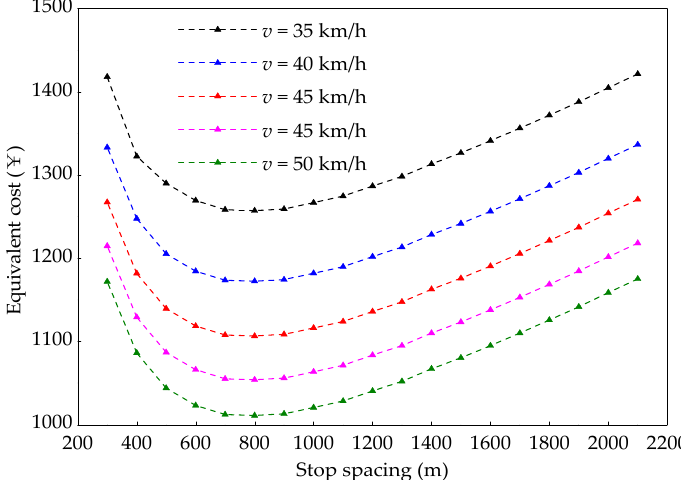
Figure 6. Equivalent cost versus stop spacing with different normal speeds.